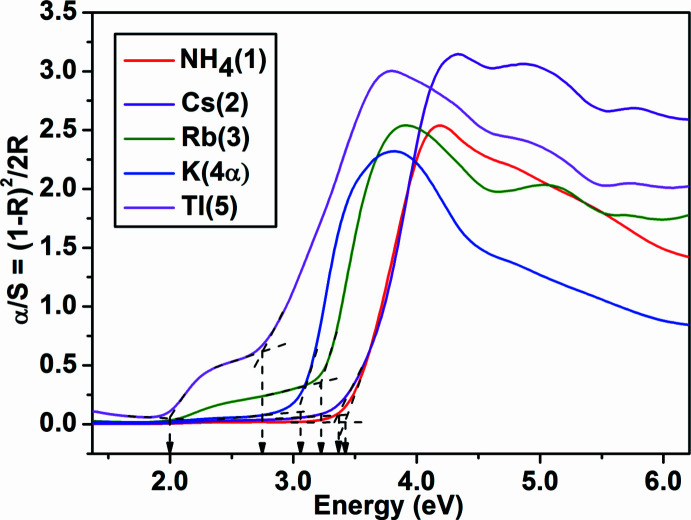
Solid state UV–visible absorption spectra for the A
2W3SeO12 [A = NH4 (1), Cs (2), Rb (3), K (4α) and Tl (5)] compounds.